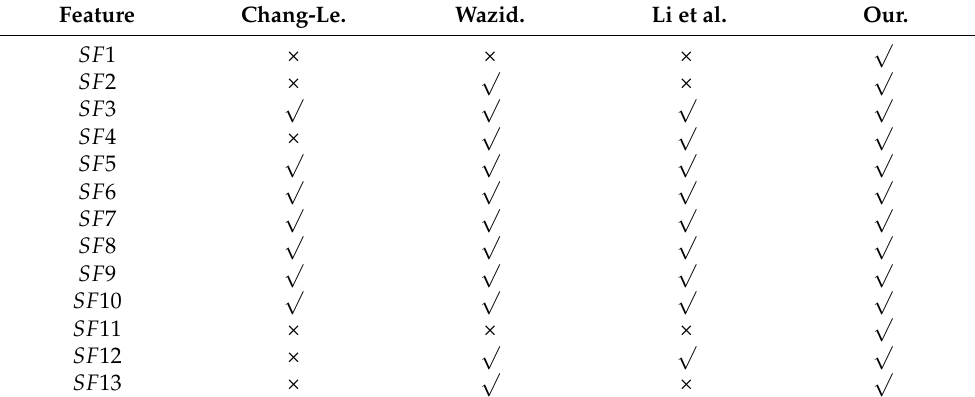
Table 4. Safety performance and function comparison. Feature Chang-Le. Wazid. Li et al. Our.